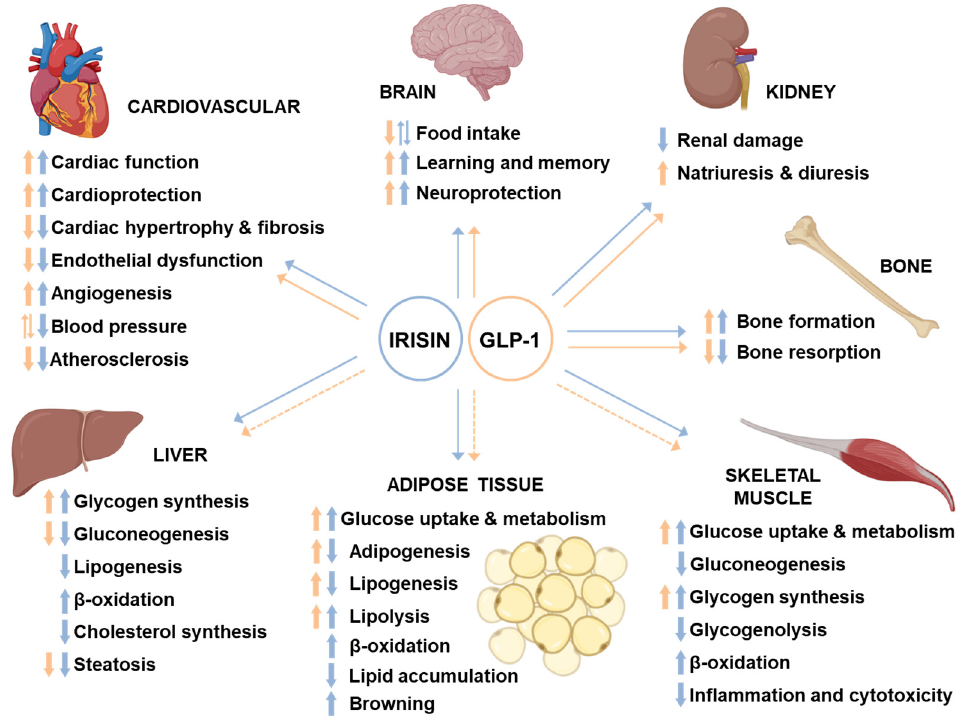
Figure 4. Pleiotropic effects of GLP-1 and irisin. Blue arrows indicate irisin effects; orange arrows indicate GLP-1 effects; dotted arrows indicate indirect effects.